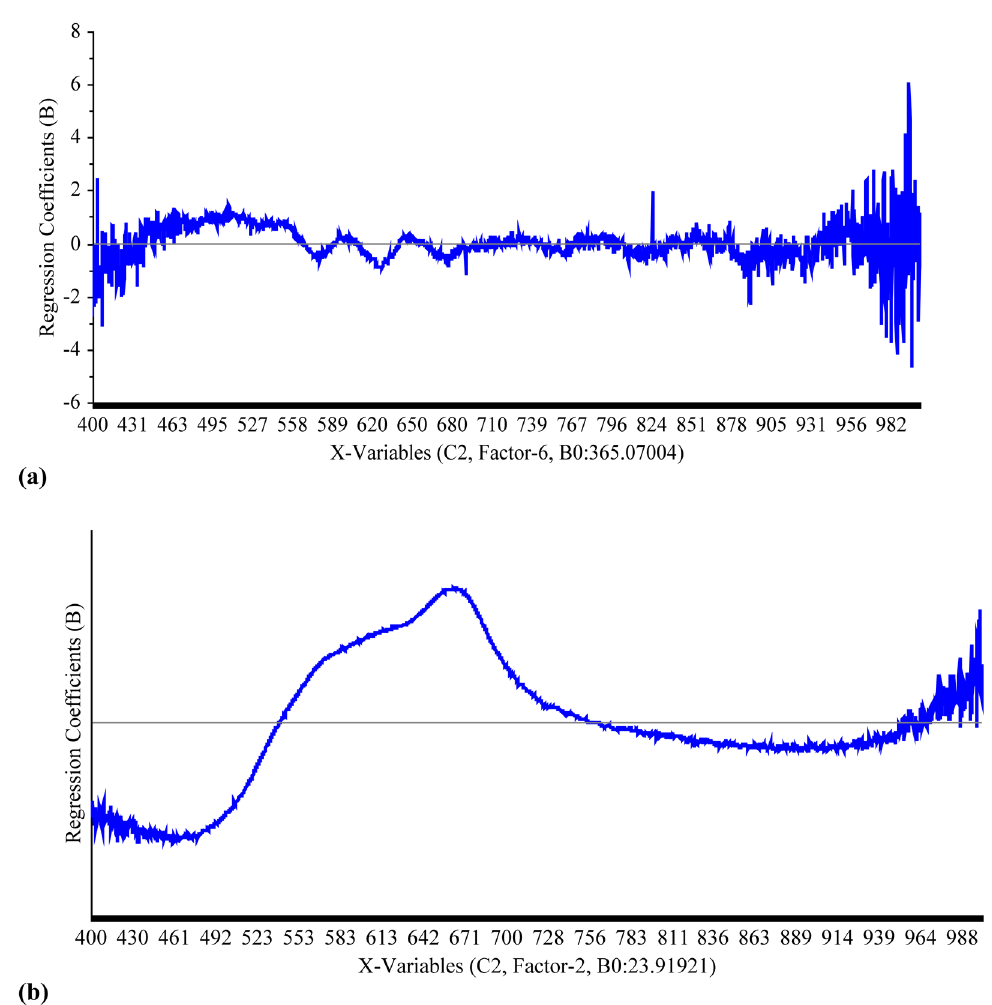
Figure 9: ( a ) Regression coe ffi cients of PLSR for predicting maltodextrin addition in butter fl y - pea extract powder; ( b ) Regression coe ffi cients of PLSR for predicting SPI addition in butter fl y - pea extract